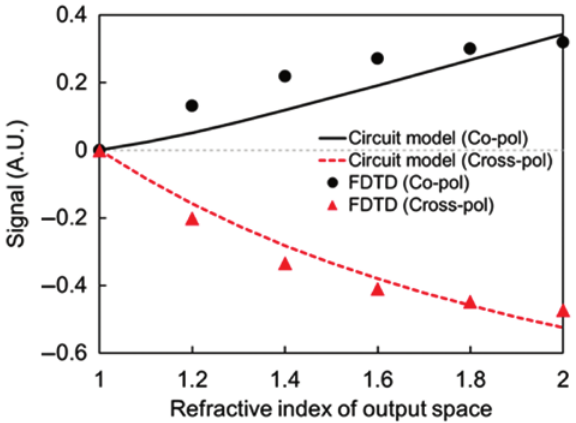
Figure 4: Variation of the anisotropic reflection signal for copolarization and cross-polarization components with respect to the refractive index of the output space. The black solid line and red dashed line indicate theoretical calculation results obtained using the circuit model for copolarization and cross-polarization, respectively. The black circle and red triangle indicate the finite-difference time-domain (FDTD) simulation for copolarization and cross-polarization,